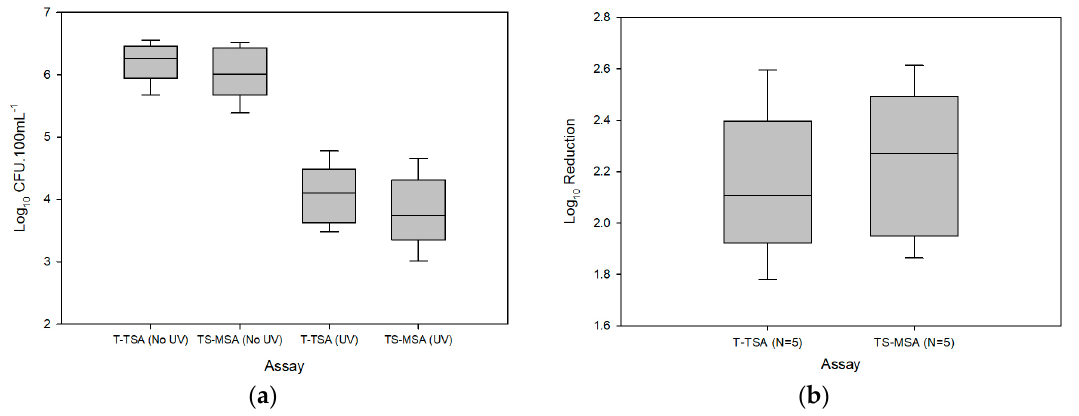
Figure 1. Hand-rinse bacteria exposed to 256 nm UV-C irradiation: ( a ) Log 10 CFU · 100 mL − 1 on TSA (T-TSA) and total staphylococci on MSA (TS-MSA) before and after exposure to dose of 220 mJ · cm − 2 (N = 5); ( b ) Log 10 reduction on T-TSA and TS-MSA (N = 5). Table 1. Log 10 colony forming units per 100 mL of raw hand-rinse water before and after exposure. Assay